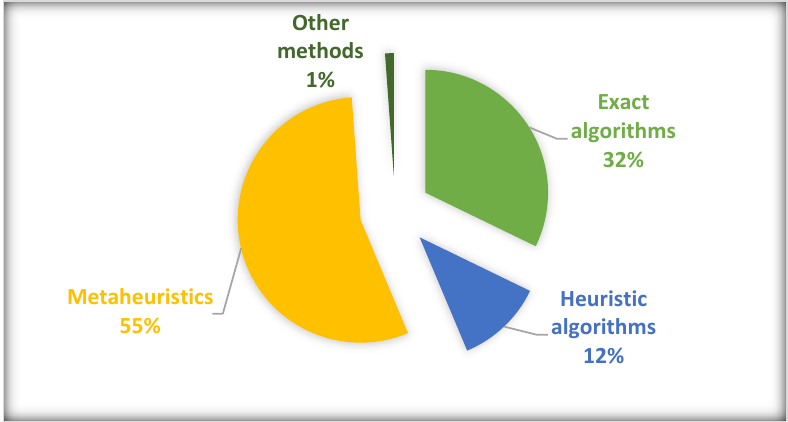
Fig. 16. Percentage distribution of solution algorithms for included HFS